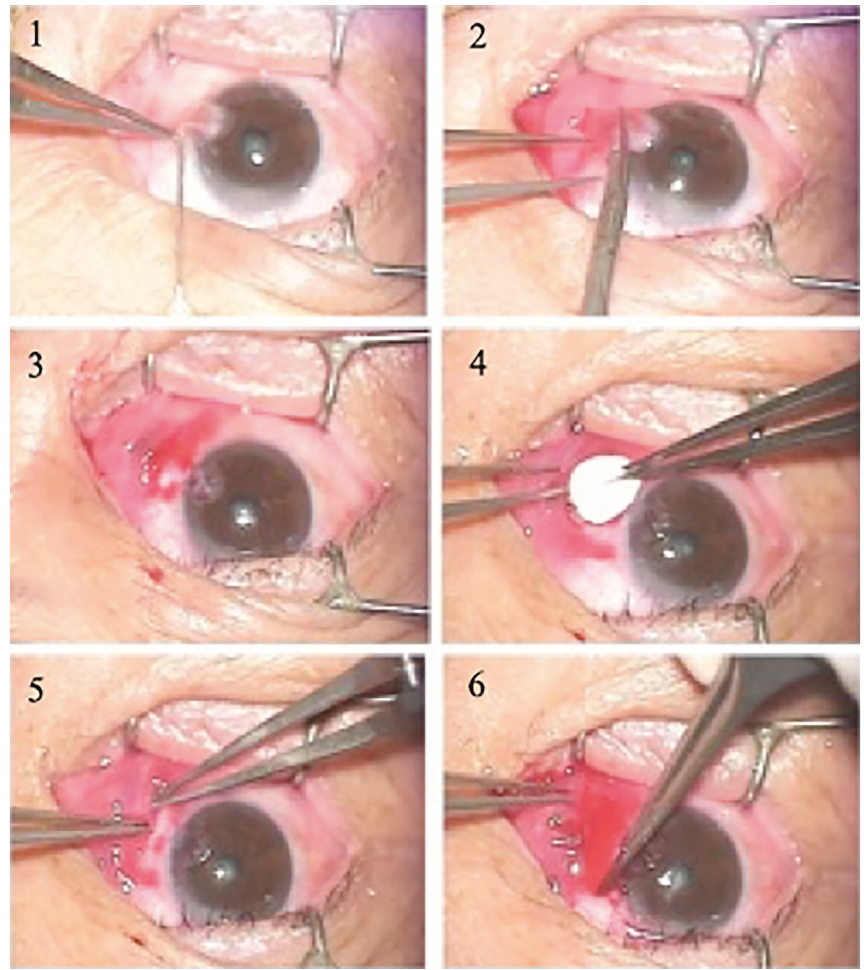
Figure 1: The surgery procedure of pterygium excision combined with Ologen implantation. 1: topical anaesthesia. 2: the head and body of the pterygium was excised by a scissor. 3: removed down to bare sclera. 4: put the Ologen under the conjunctival flap. 5: left a 2.0mm width of bare sclera at the limbus. 6: sutured the flap with 10-0 nylon on the sclera. Table 1: Preoperative characteristics of patients in both